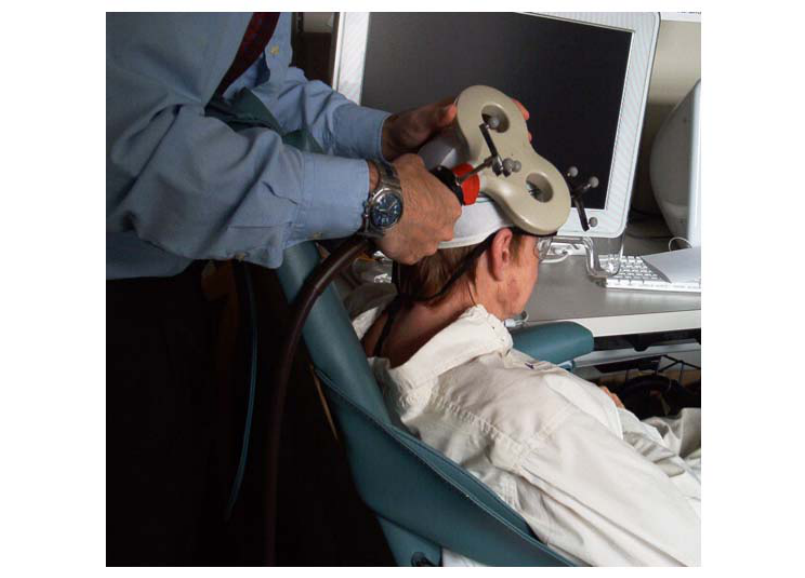
FIGURE 4. Picture showing the application of rTMS treatment; the rTMS coil is held over the subject’s